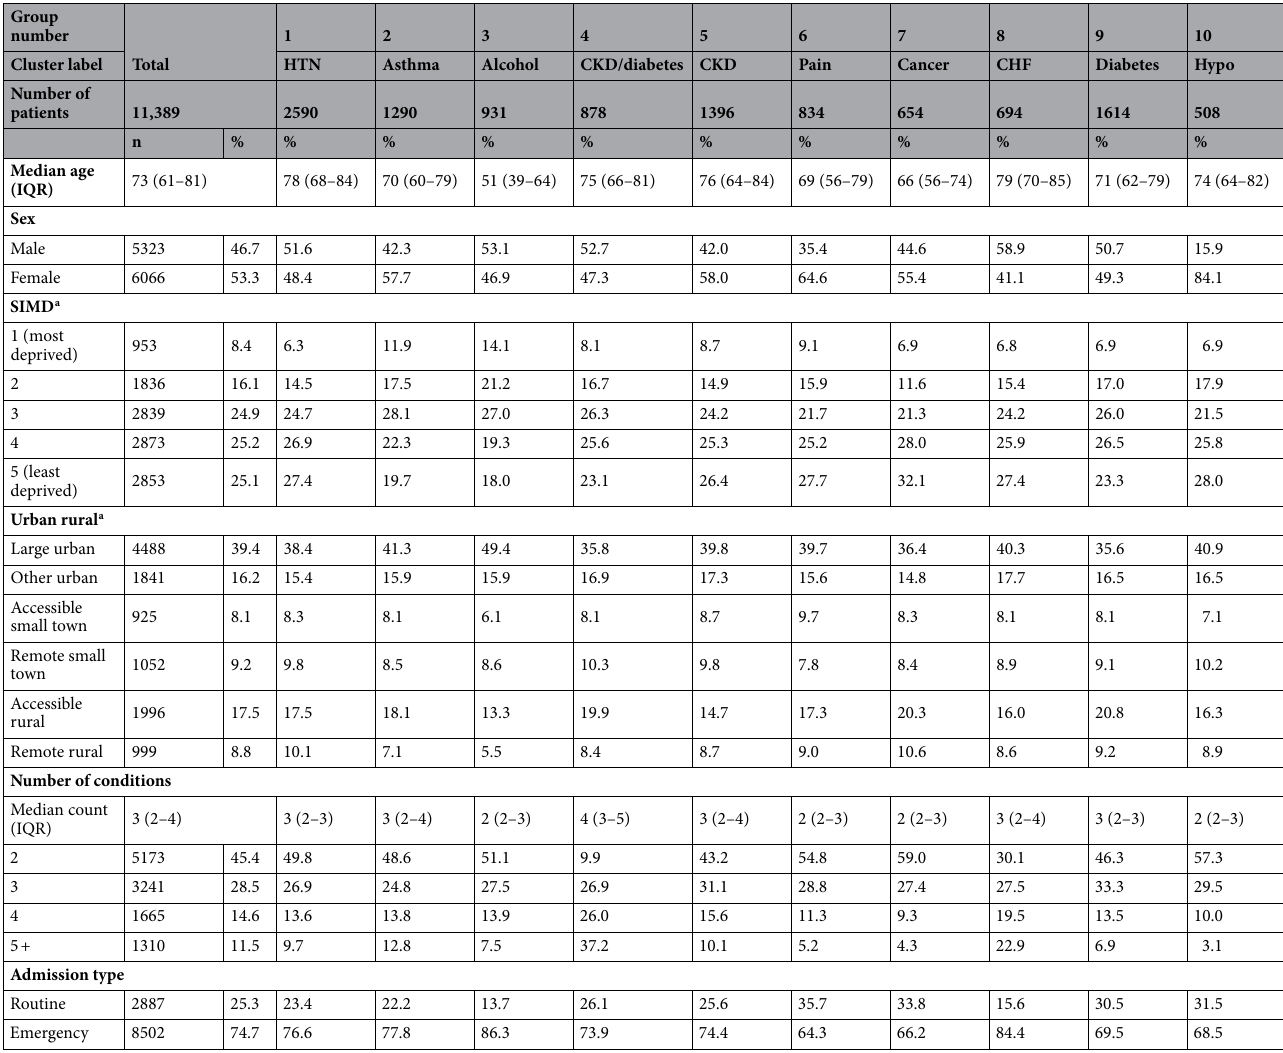
Table 5. Characteristics by patient group. HTN, hypertension; CKD, chronic kidney disease; CHF, chronic heart failure; hypo, hypothyroidism; IQR, inter-quartile range; SIMD, Scottish Index of Multiple Deprivation. a 35 patients had missing values for SIMD category and 88 patients had missing values for Urban Rural